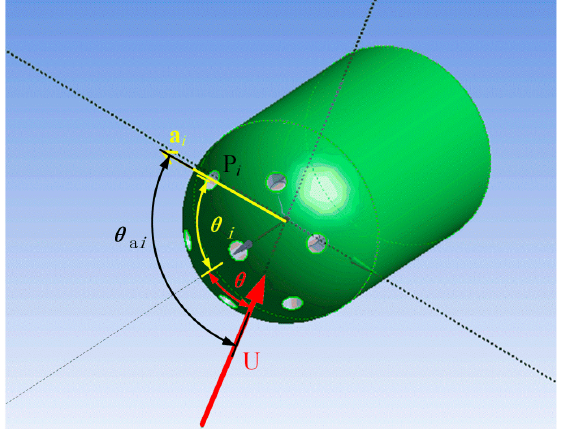
Figure 5. Calibration coordinate system of the hemispherical seven-hole probe.